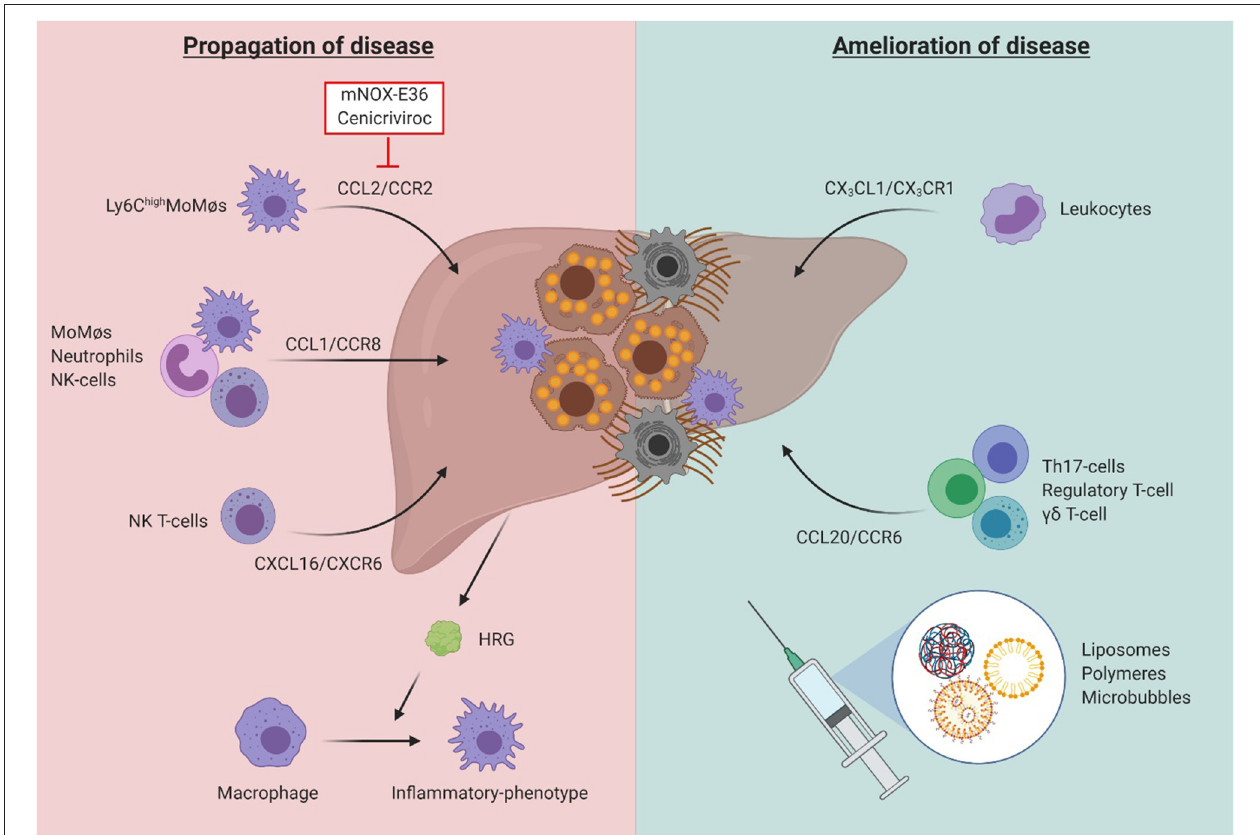
FIGURE 7 | The dual role of inflammatory cells in liver fibrosis. While the chemokine-axes CCL2/CCR2, CCL1/CCR8, and CXCL16/CXCR6 have been shown to play a role in disease propagation through induction of a pro-inflammatory and pro-fibrogenic environment, the axes CX 3 CL1/CX 3 CR1, and CCL20/CCR6 were identified to be essential to obtain amelioration of liver function after acute or chronic damage. Besides its effects on inflammatory cell recruitment, the liver environment also influences the function of immune cells, such as through secretion of histidine-rich glycoprotein (HRG), promoting the polarization of macrophages toward an inflammatory phenotype. While therapeutic agents targeting the inflammatory system may be a promising strategy, their potential off-target effects limit their future use. Cell-specific nano-scale delivery systems such as liposomes, polymers and microbubbles may therefore aid in the development of such inflammatory-specific therapeutic